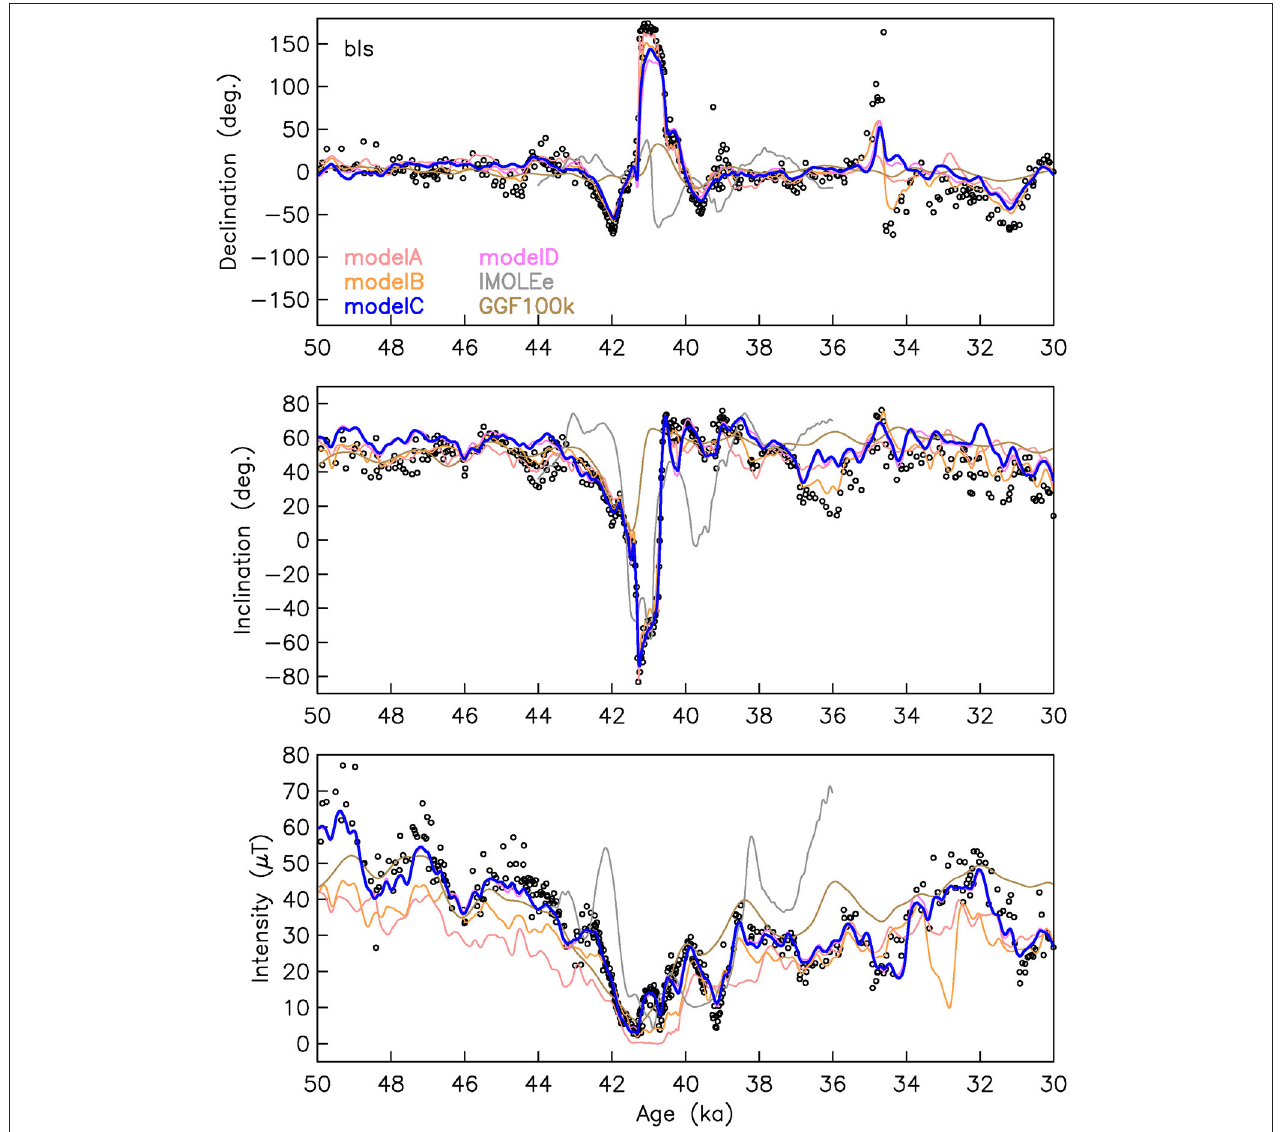
FIGURE 2 | Comparison of the six model predictions (colored lines) to the Black Sea record (black circles) (Nowaczyk et al., 2012, 2013) (c.f. Figure 1 and Table S1 ) for field components declination, inclination and RPI from top to bottom. Model C (LSMOD.2) is our preferred